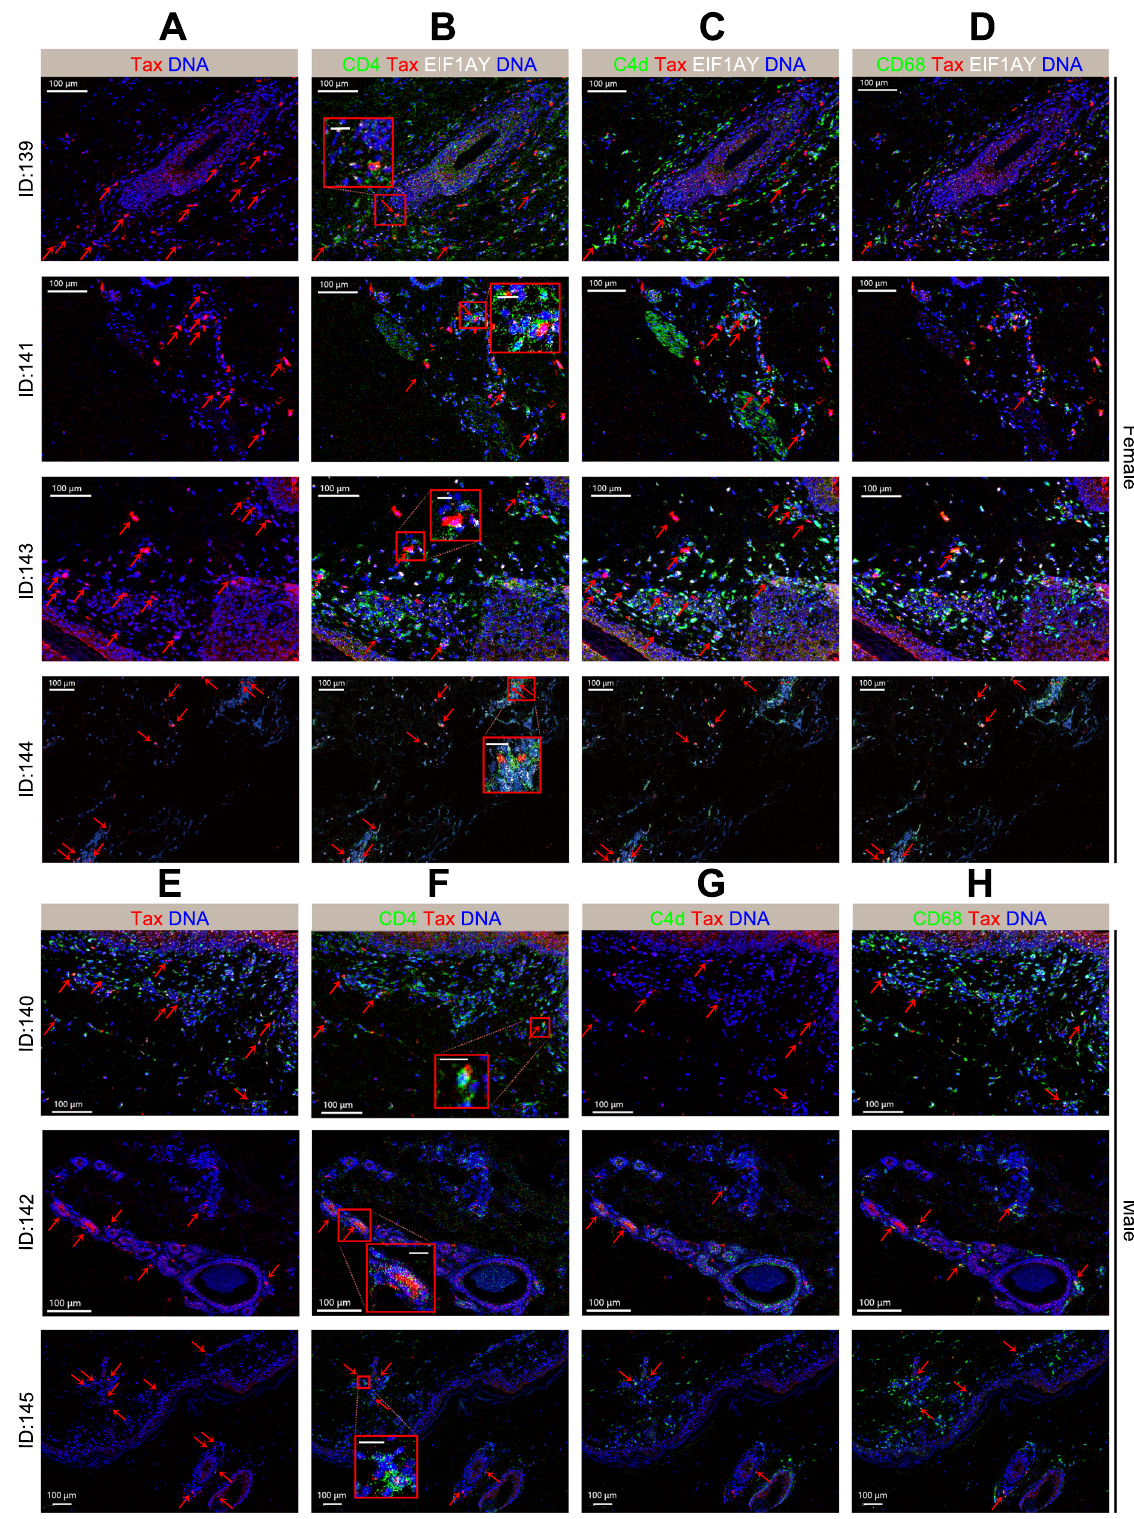
Fig.4|HTLV-1speci fi cTaxproteindetectedontheaGVHDskintissuesbyIMC. Representative IMC images of two independently stained skin tissues from 7 aGVHD patients show the overlap of Tax (red), DNA (blue) and different immune response markers. Displayed channels for each column were: A Tax (red)/DNA (blue); B CD4 (green)/Tax (red)/EIF1AY (white)/DNA (blue); C C4d (green)/Tax (red)/EIF1AY (white)/DNA (blue); D CD68 (green)/Tax (red)/EIF1AY (white)/DNA